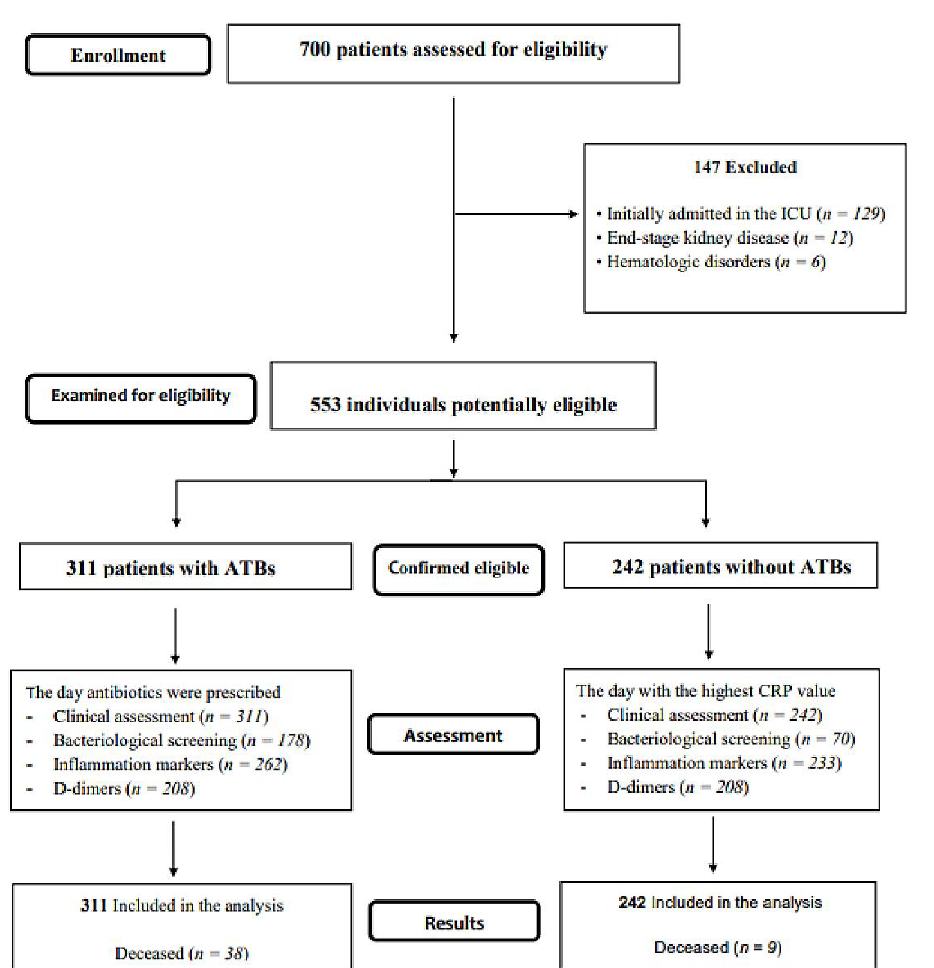
Figure 1. The flow diagram of the study describing the methods: participants’ recruitment, inclusion, exclusion, and outcomes.